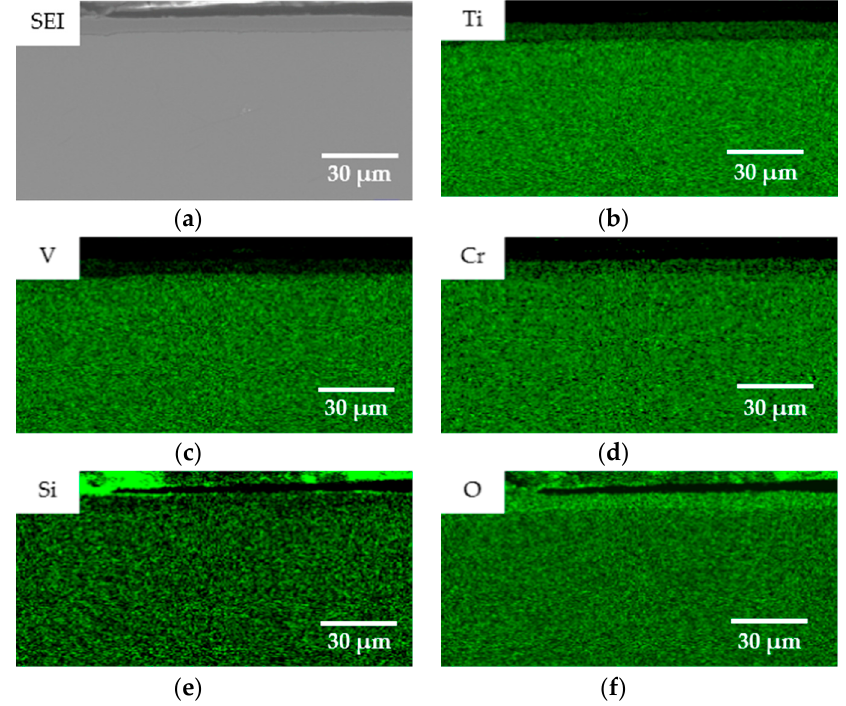
Figure 4. Scanning electron microscope (SEM) morphology and energy dispersive spectrometer (EDS) mapping of the oxide layer in TF550 alloy after oxidation at 873 K for 100 h. ( a ) Secondary electron image (SEI); ( b ) Ti element; ( c ) V element; ( d ) Cr element; ( e ) Si element; and ( f ) O element.